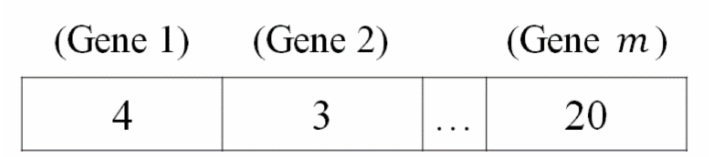
Figure 6. Chromosome structure using integer-valued